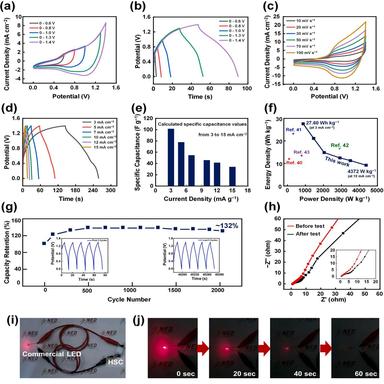
Electrochemical measurements of the fabricated hybrid supercapacitor (HSC) device. (a) CV and (b) GCD curves at various potential windows (from 0 to 1.4 V). (c) CV curves at various scan rates and (d) GCD curves at various current densities. (e) The calculated specific capacitance with the GCD results. (f) Energy and power densities, (g) cycling stability (for 2,000 GCD cycles), and (h) EIS curves before and after the stability test. (i) Illumination of the commercial LED with the energy stored in the HSC d